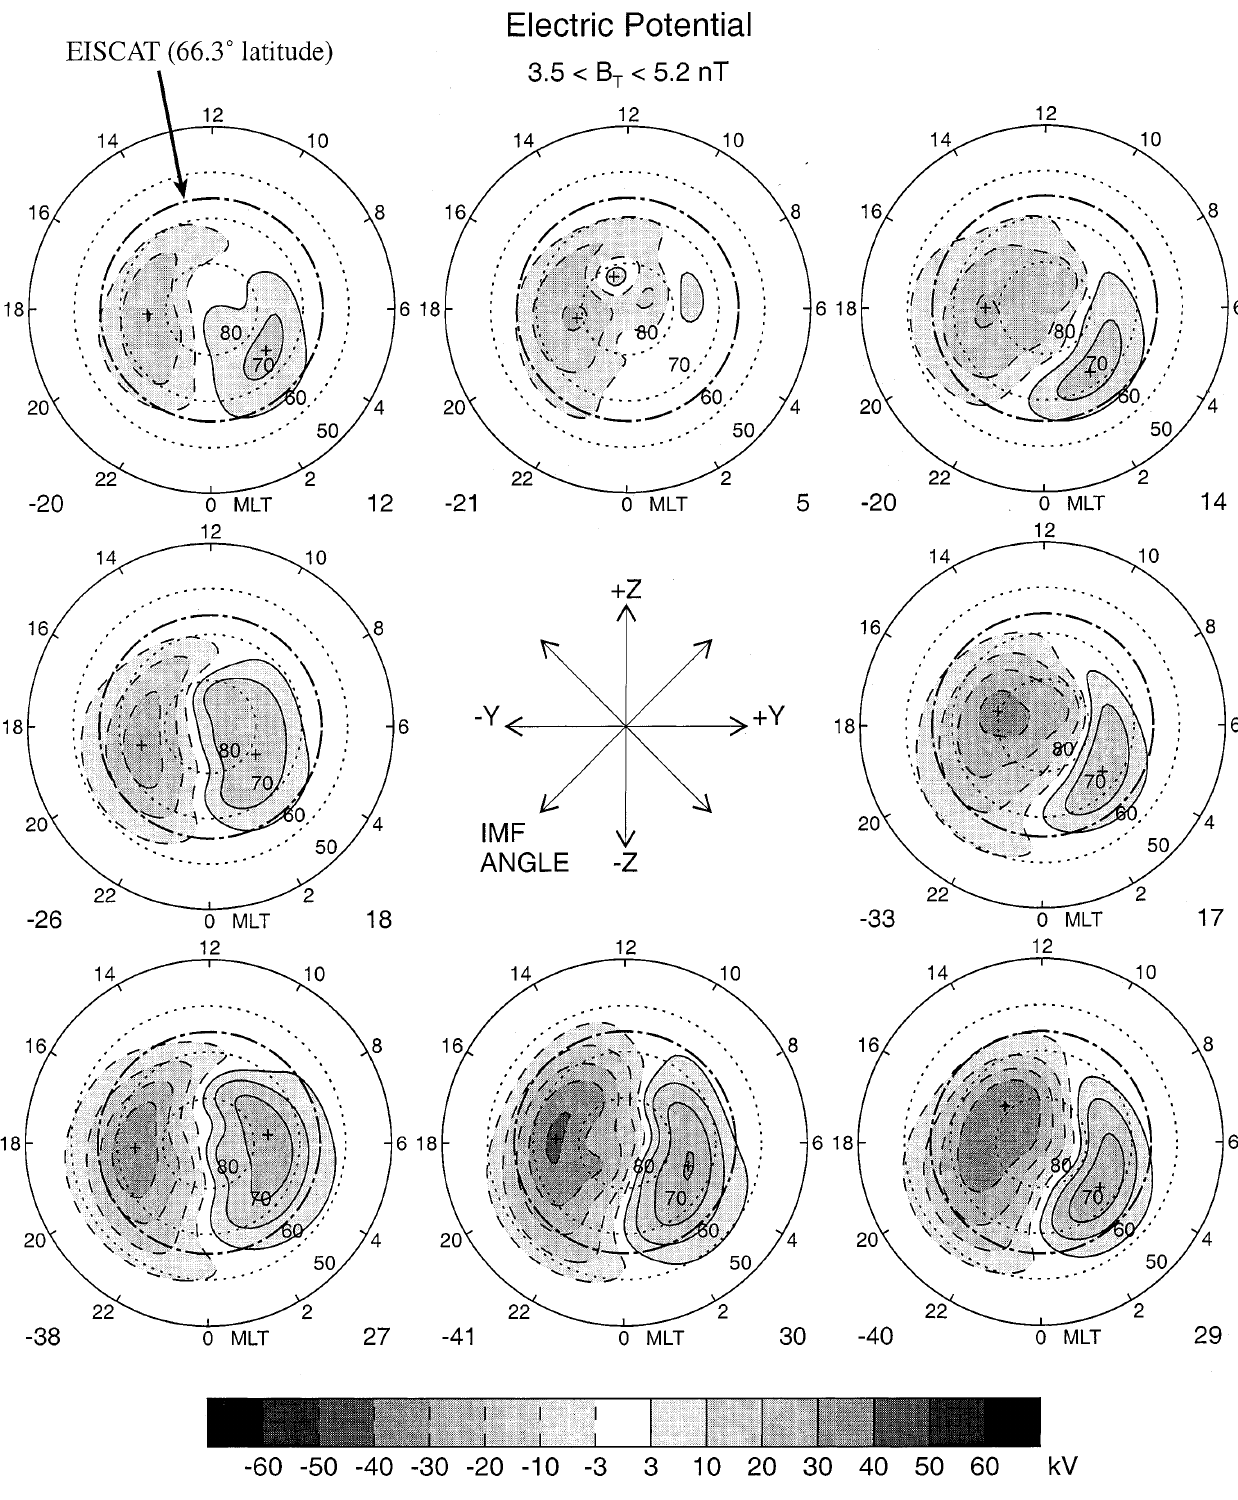
dashed lines , respectively. The EISCAT radar location at 66.3 (cid:176) Fig. 1. Ionospheric potential contour plots (plasma streamlines) for magnetic latitude is marked by the dotted-dashed circle , (after eight 45 (cid:176) intervals of the IMF vector in the GSM Y–Z plane, and where the total field strength in this plane (B ) lies between 3.5 T and 5.2 nT. Positive and negative potentials are indicated by solid and